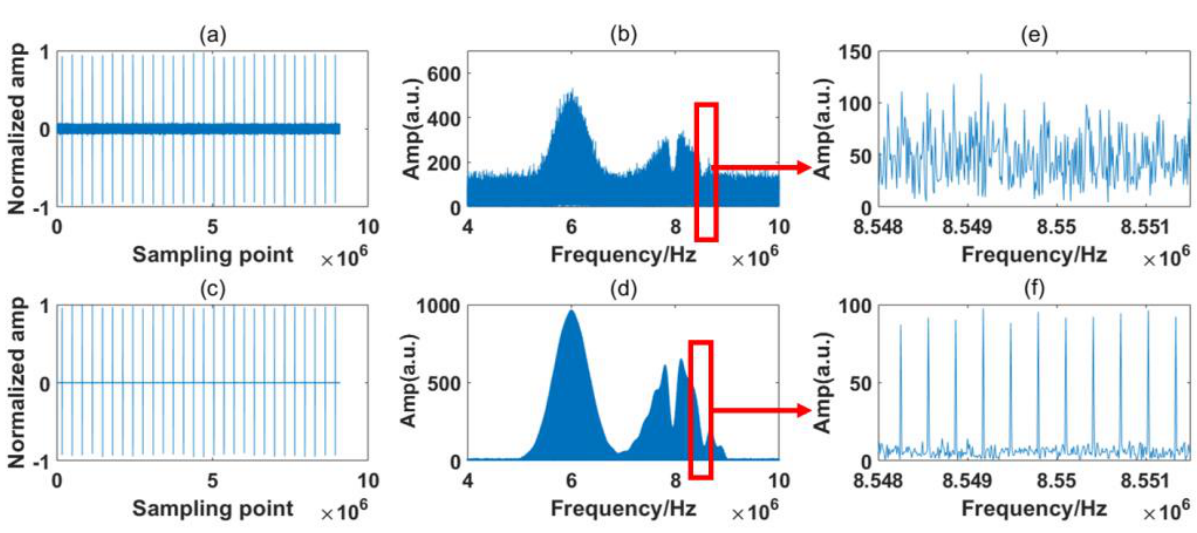
Figure 6. Simulation of the signal path signal. ( a ) Raw time domain signal; ( b ) raw frequency domain signal; ( c ) corrected time domain signal; ( d ) corrected frequency domain signal; ( e ) Magnified view of red rectangle shown in ( b ); ( f ) Magnified view of red rectangle shown in ( d ).